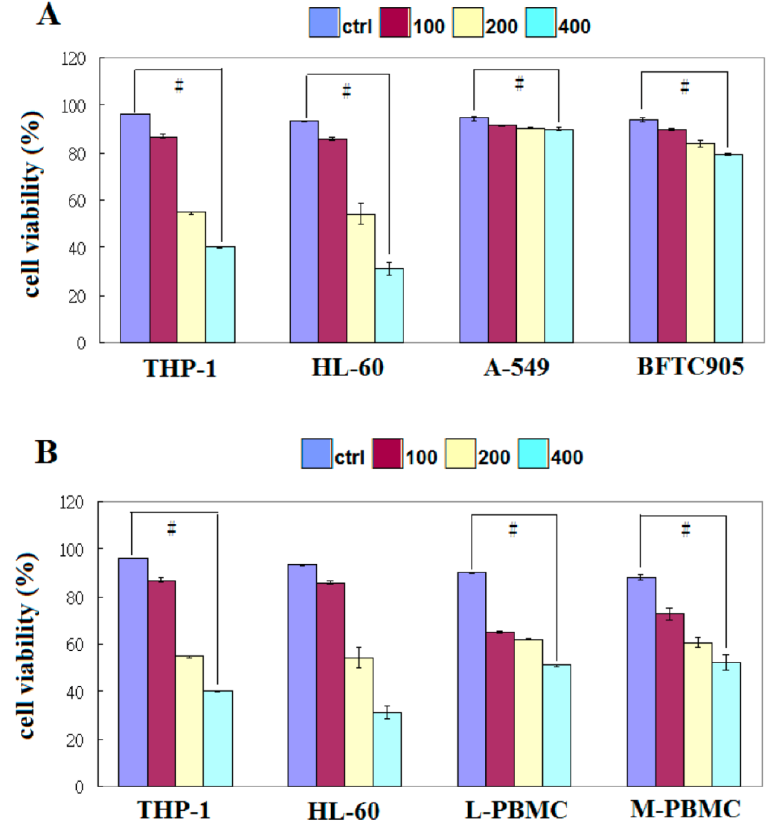
Figure 1. ( A ) The effect of 24 h of treatment with EFW at 100 μ g/mL (red), 200 μ g/mL (yellow), and 400 μ g/mL (green) or with distilled water (vehicle control; blue) on the growth of THP-1, HL-60, A-549, BFTC905, and PBMCs; ( B ) The effect of EFW on the cell proliferation of THP-1, HL-60, L-PBMC, and M-PBMC cells was analyzed by flow cytometry. The data represent the mean ± S.D. of three independent experiments, and the symbol # indicates significance of p < 0.001 compared with the control